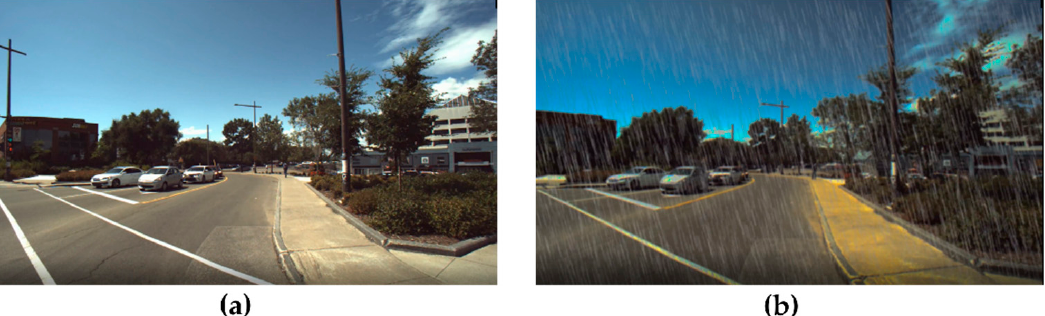
Figure 2. Extracted images from simulated video dataset showing ( a ) without rain and ( b ) with rain scenarios considered in this experiment.